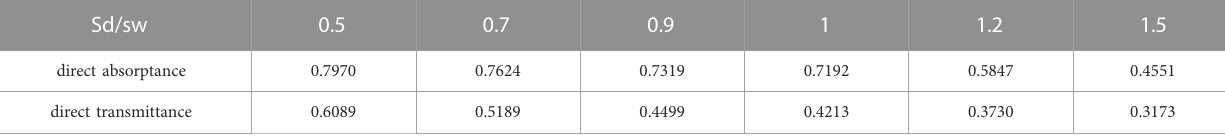
TABLE 5 Summary of direct absorptance and direct transmittance, for different ratios of slat distance to slat width.